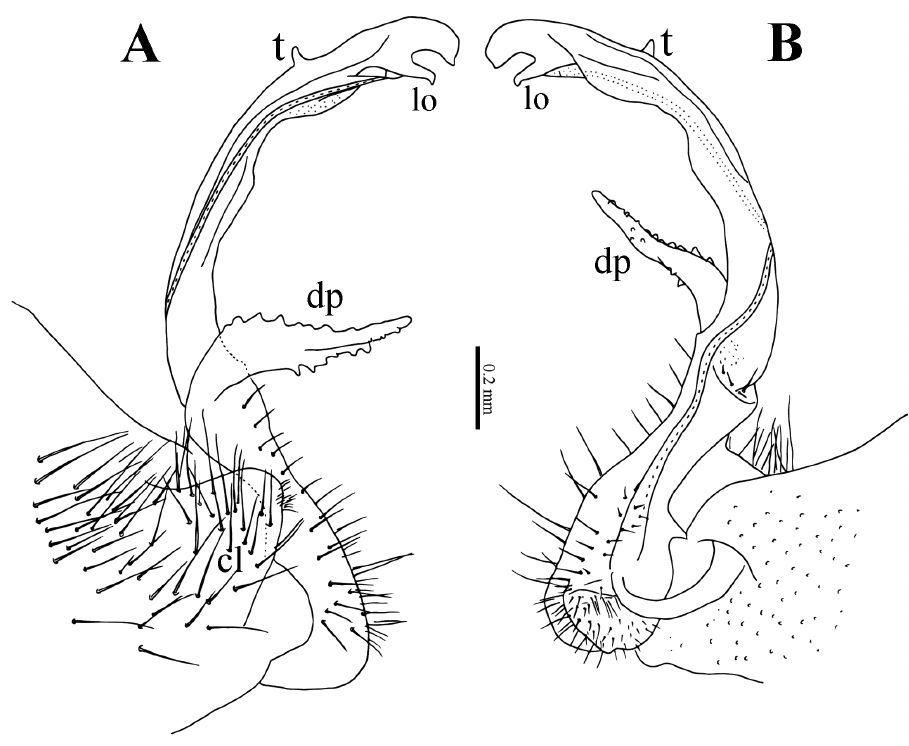
Figure 13. E. parvus sp. n., male paratype from Cave Tham Nam Long. A–B right gonopod, lateral and mesal views. Abbreviations: cl = coxal lobe; dp = distofemoral process; lo = lobe; t =